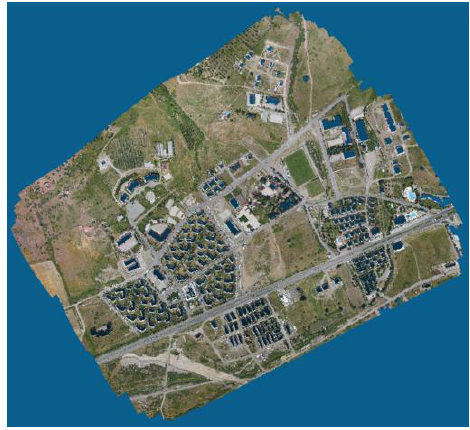
Figure 4. RGB encoded ground points of study area 4.